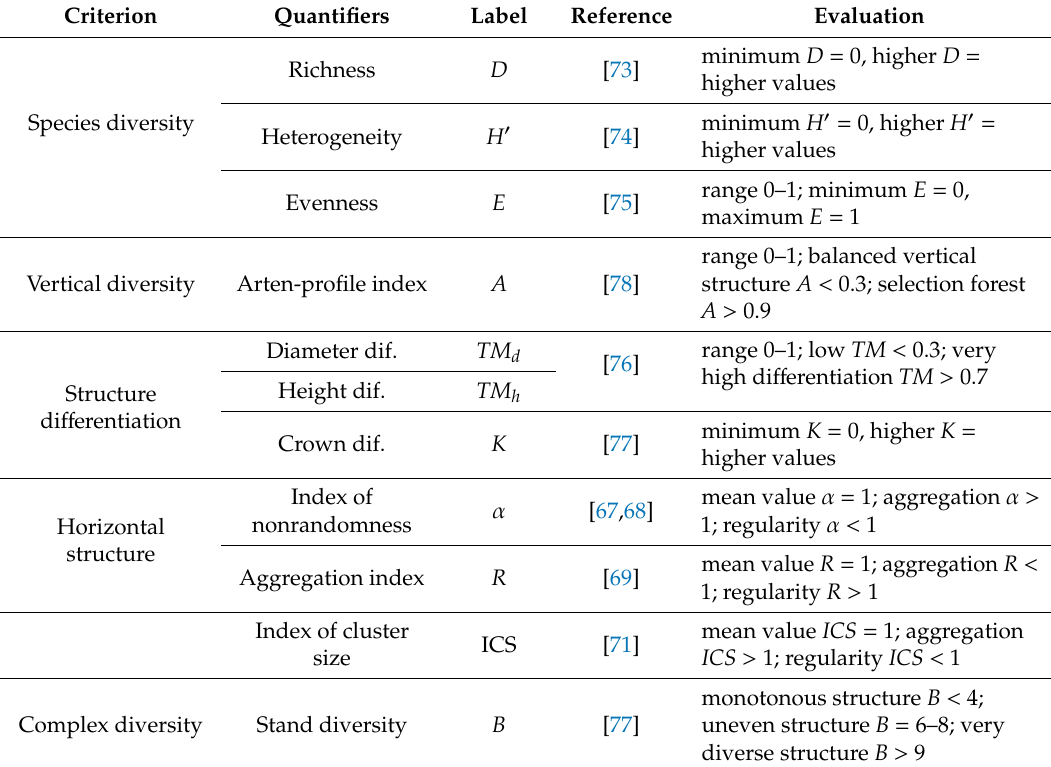
Table 2. Overview of indices describing the stand structure and their common